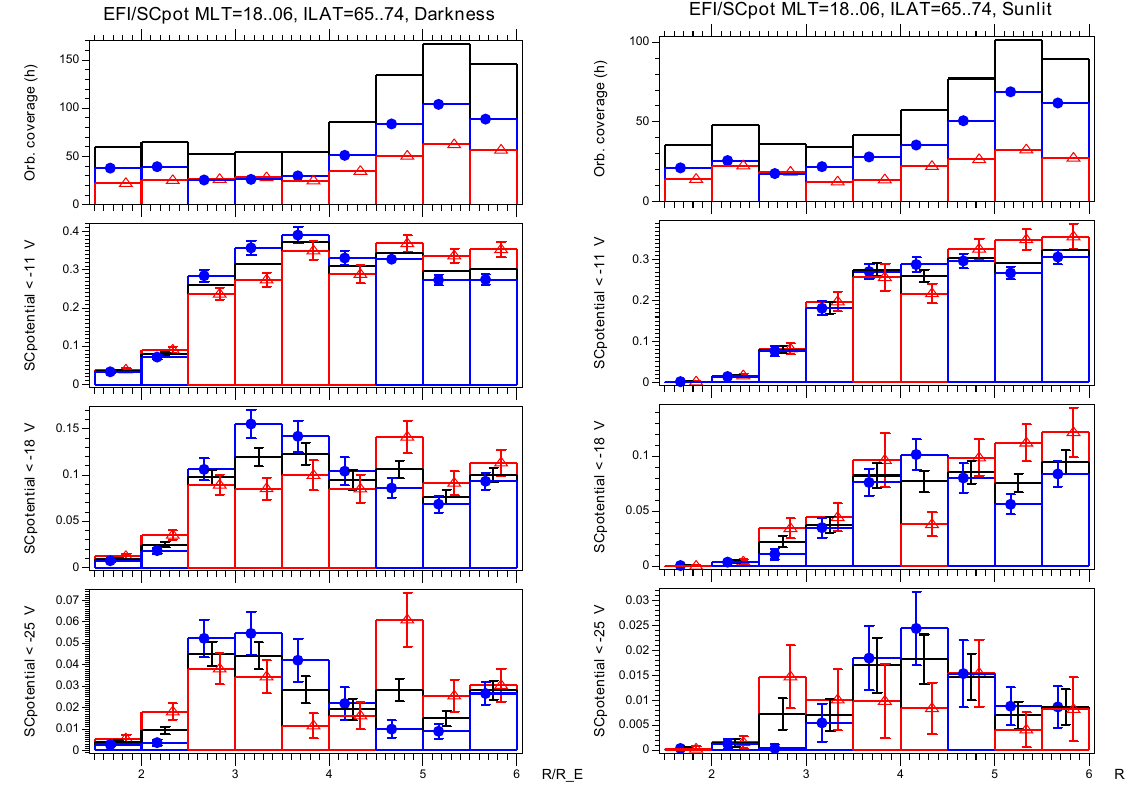
Fig. 4. Occurrence frequency of nightside auroral cavities for conditions when the ionospheric footpoint is in darkness (left subplot) and sun-illuminated (right subplot). The top panel of each subplot is the orbital coverage in hours while the remaining panels give the occurrence frequency for spacecraft potential thresholds − 11V, − 18V and − 25V. Low K p ( ≤ 2) is shown by blue lines with filled dots, high K p ( > 2) by red lines and open triangles and all K p ’s put together by solid black line with no symbol. The horizontal axis in each subplot is the radial distance from 1.5 to 6 R E . Error bars are shown except when they are insignificantly small. If the orbital coverage is less than 20 min, the corresponding occurrence frequencies are not